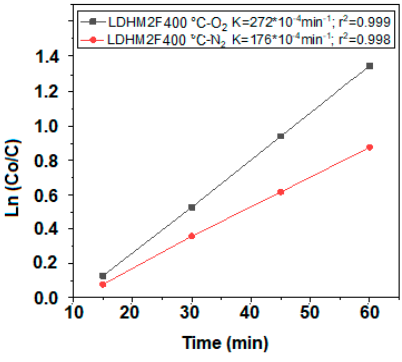
Figure 14. Kinetic constants in the photodegradation of 2,4,6-trichlorophenol in the presence and absence of oxygen.